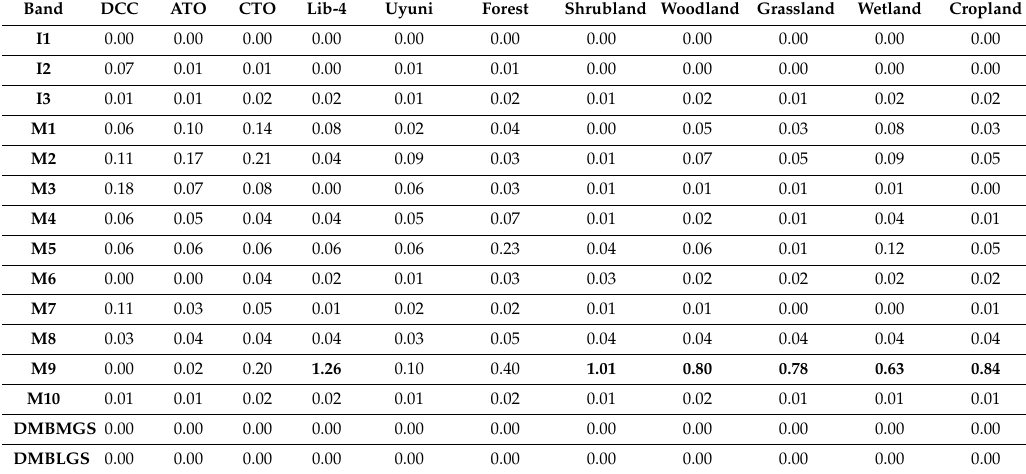
Table 7. NOAA-20 VIIRS V2 RSR Earth-reflected scene-dependent γ for specified 1% extended bandpass limits, shown in %.